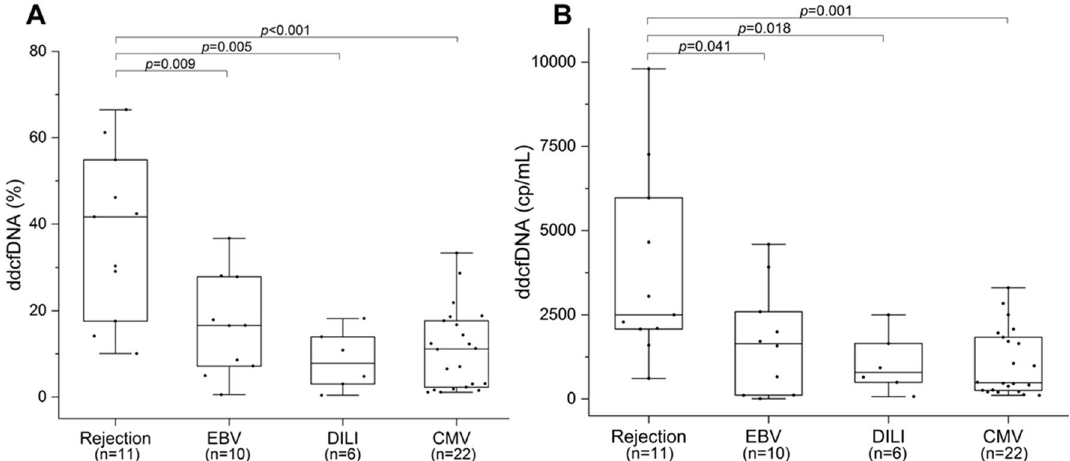
Figure 3. dd-cfDNA levels in different subgroups. ( A ) Box plots of plasma dd-cfDNA%, horizontal line represents the median; bottom and top of each box represents 25th and 75th percentiles. Dots are individual results. ( B ) Box plots of plasma dd-cfDNA (cp/mL). p-values were determined by Mann–Whitney U test.